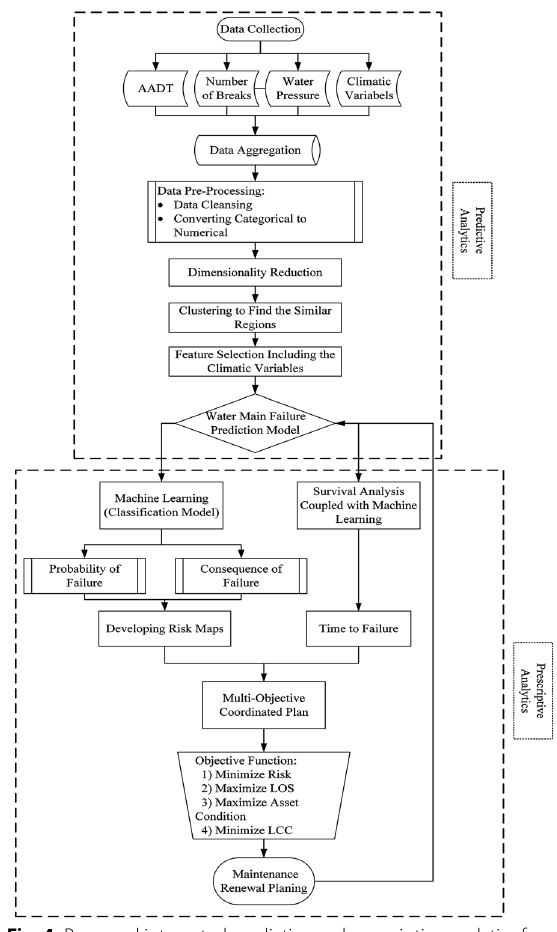
Fig. 4 Proposed integrated predictive and prescriptive analytics for smart water main asset